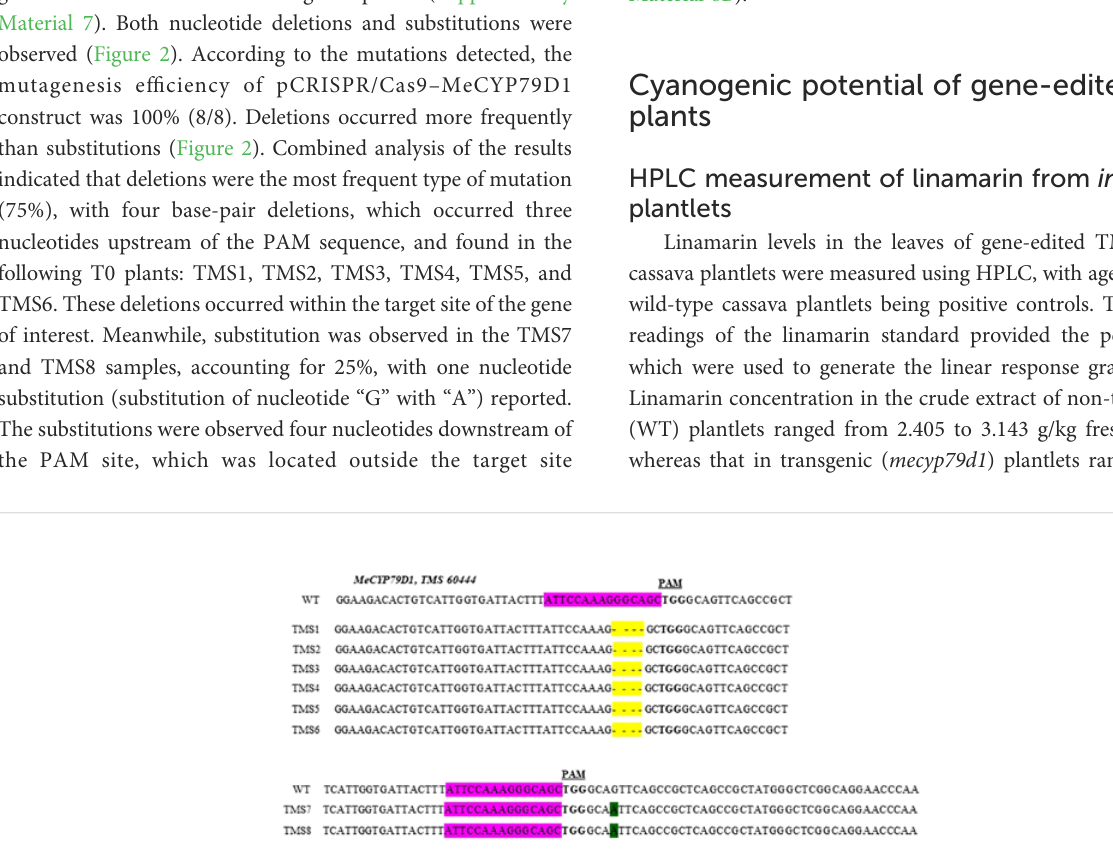
FIGURE 2 Partial sequences of the mecyp79d mutant alleles aligned with respective wild-type (WT) sequences. Sequences from each mutant plant (TMS1 - TMS8) are shown below the respective WT reference sequences. Nucleotide deletions are highlighted in yellow, while substitutions – in green. The MeCYP79D1 target region is highlighted purple in the wild-type (WT) reference sequence, with the protospacer adjacent motif (PAM) shown in bold